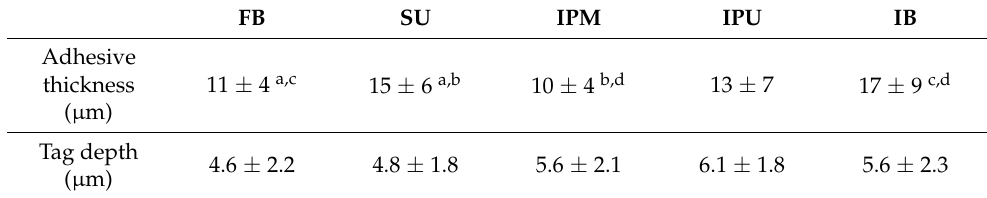
Table 3. Adhesive layer thickness and tag depth values (means and standard deviations) of the five adhesives. FuturaBond M+—“FB”, Scotchbond Universal—“SU”, Iperbond Max—“IPM”,